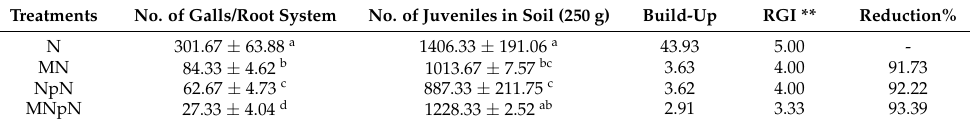
Table 4. Effect of mycorrhizal inoculation and n-HAP on M. incognita under greenhouse conditions.